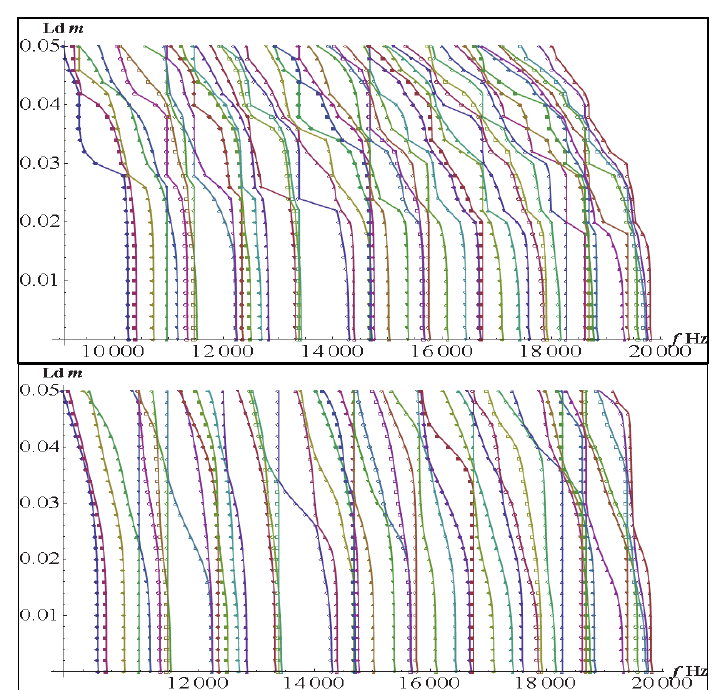
Figure 4: Shifts of natural frequencies in the range of 10-20 kHz.